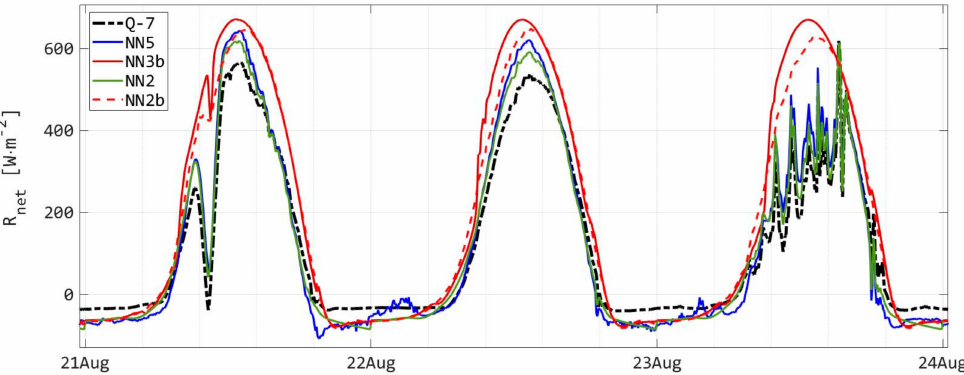
Figure 1. Time series of measured (Q-7) and neural network models of net radiation, 2017 experiment. Three example days show a range of sky conditions, including total eclipse on 21